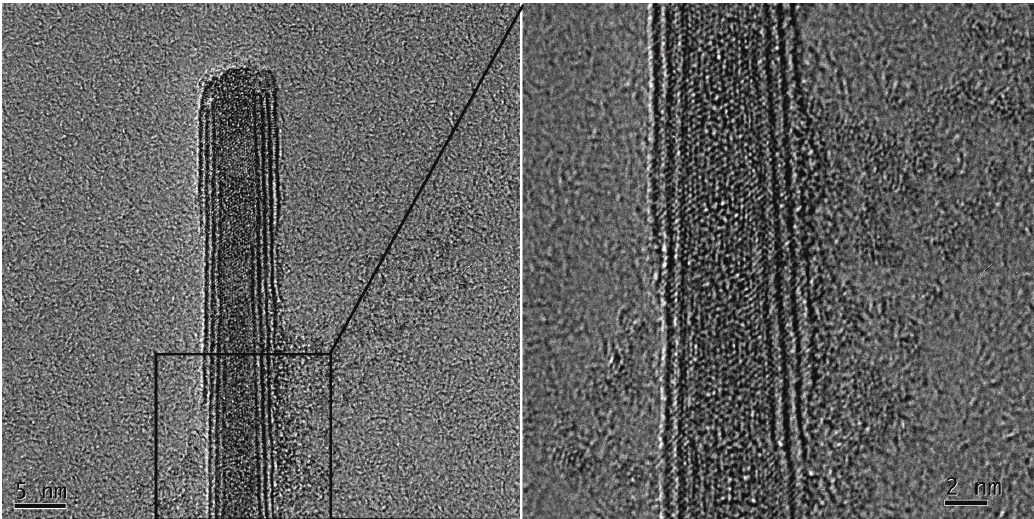
Figure 9. TEM images of nanoclusters surrounding daughter nanotubes. Presumably, the clusters were generated by the condensation of tungsten and sulfur atoms or WS molecular clusters from the vapor phase created by the plasma treatment of the multiwall WS 2